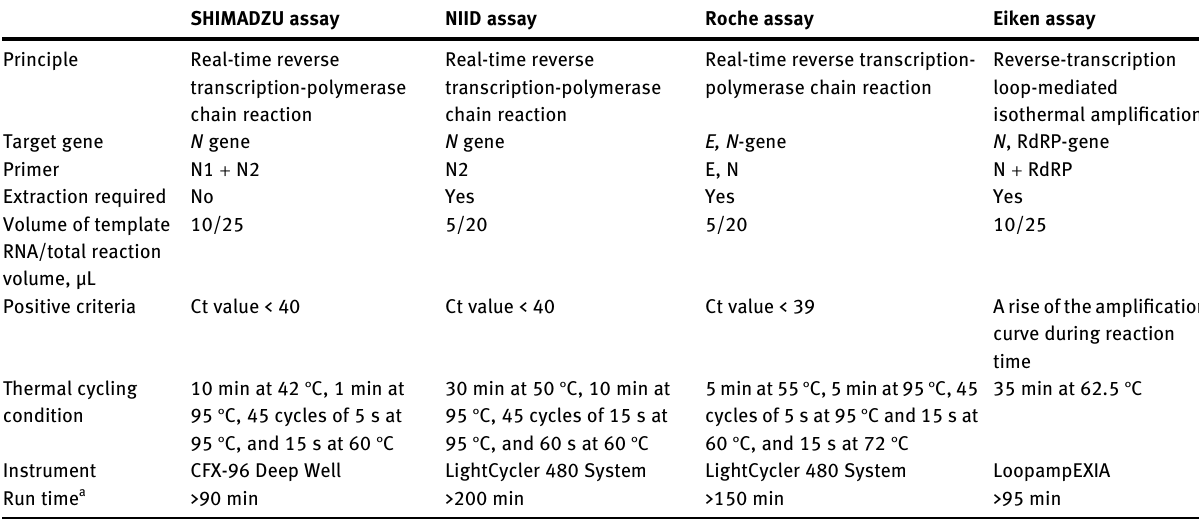
Table  : Summary of the SARS-CoV-  detection assays evaluated in this